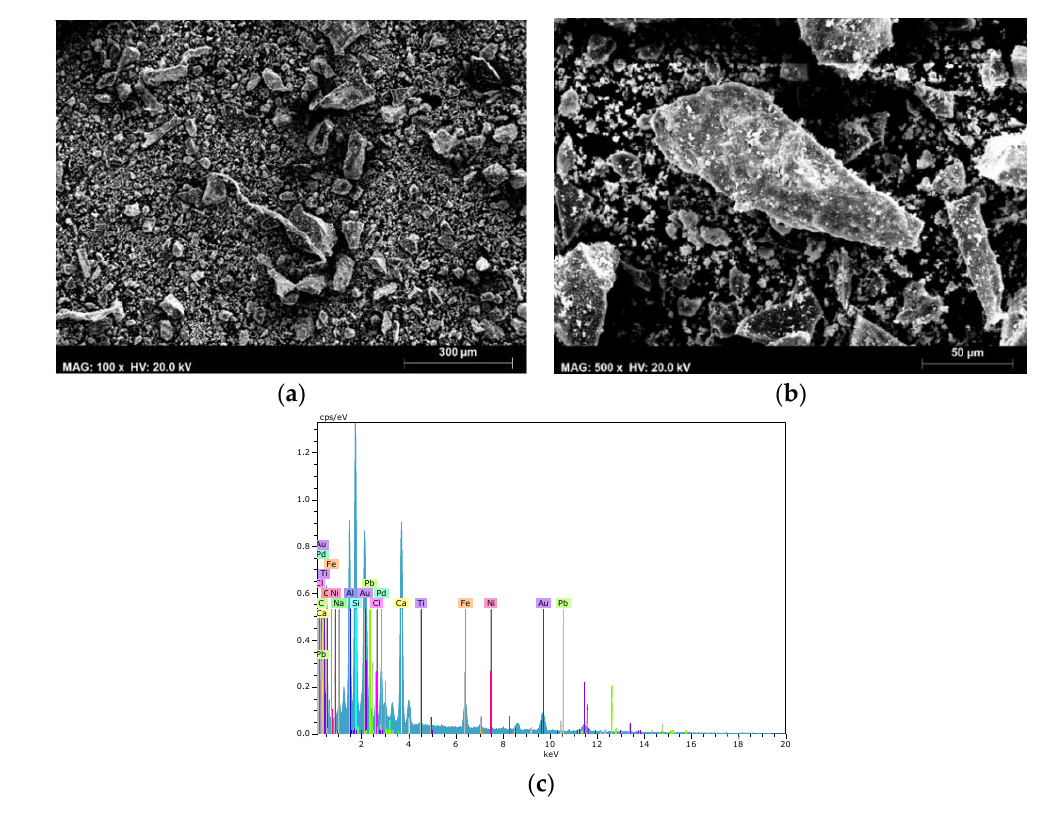
Figure 2. SEM ( a , b ) and EDS ( c ) of MIBA.